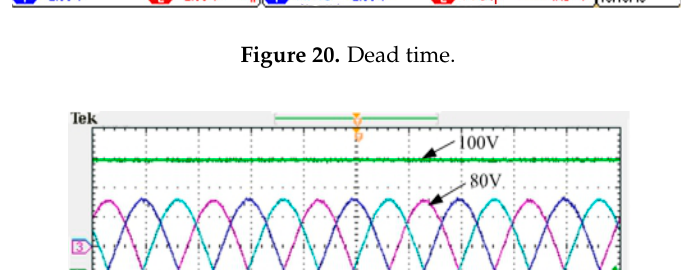
Figure 20. Dead time.